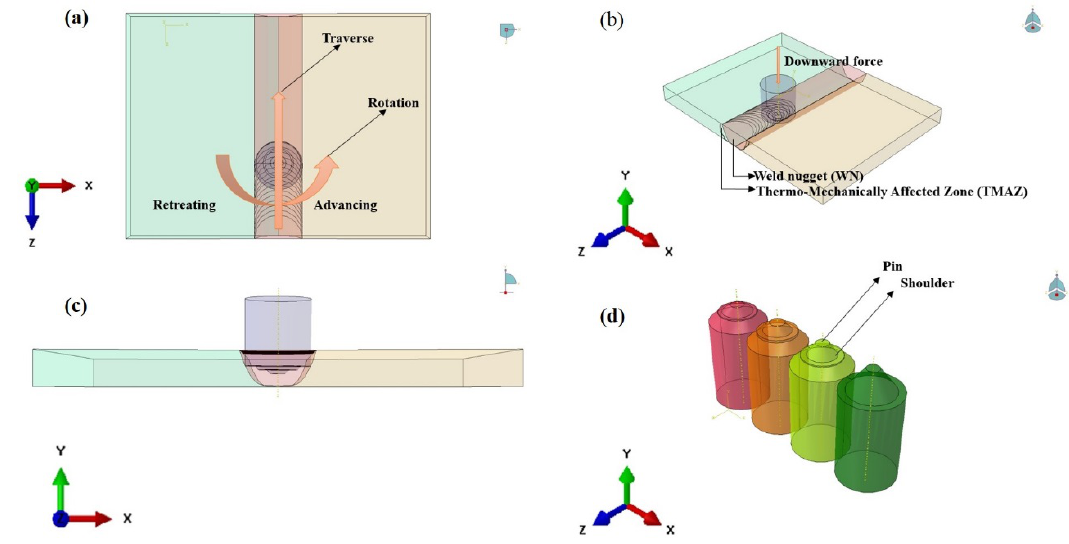
Figure 1. FSW and tool schematics. ( a ) Top; ( b ) side; ( c ) front; ( d ) tool designs. Images not to